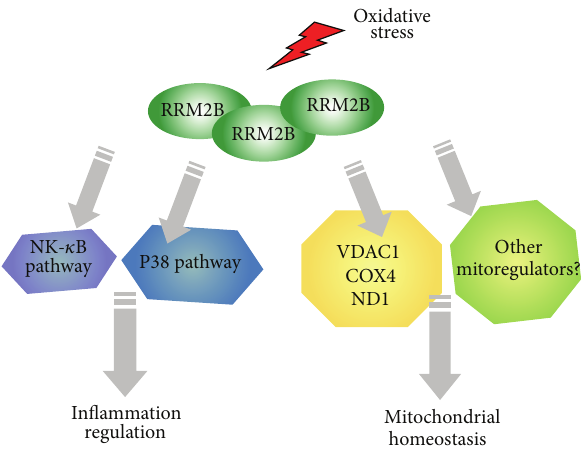
Figure 5: A model of RRM2B-mediated regulation of inflammatory NF- 𝜅 B and p38 pathways and mitochondrial pathways upon oxida- tive